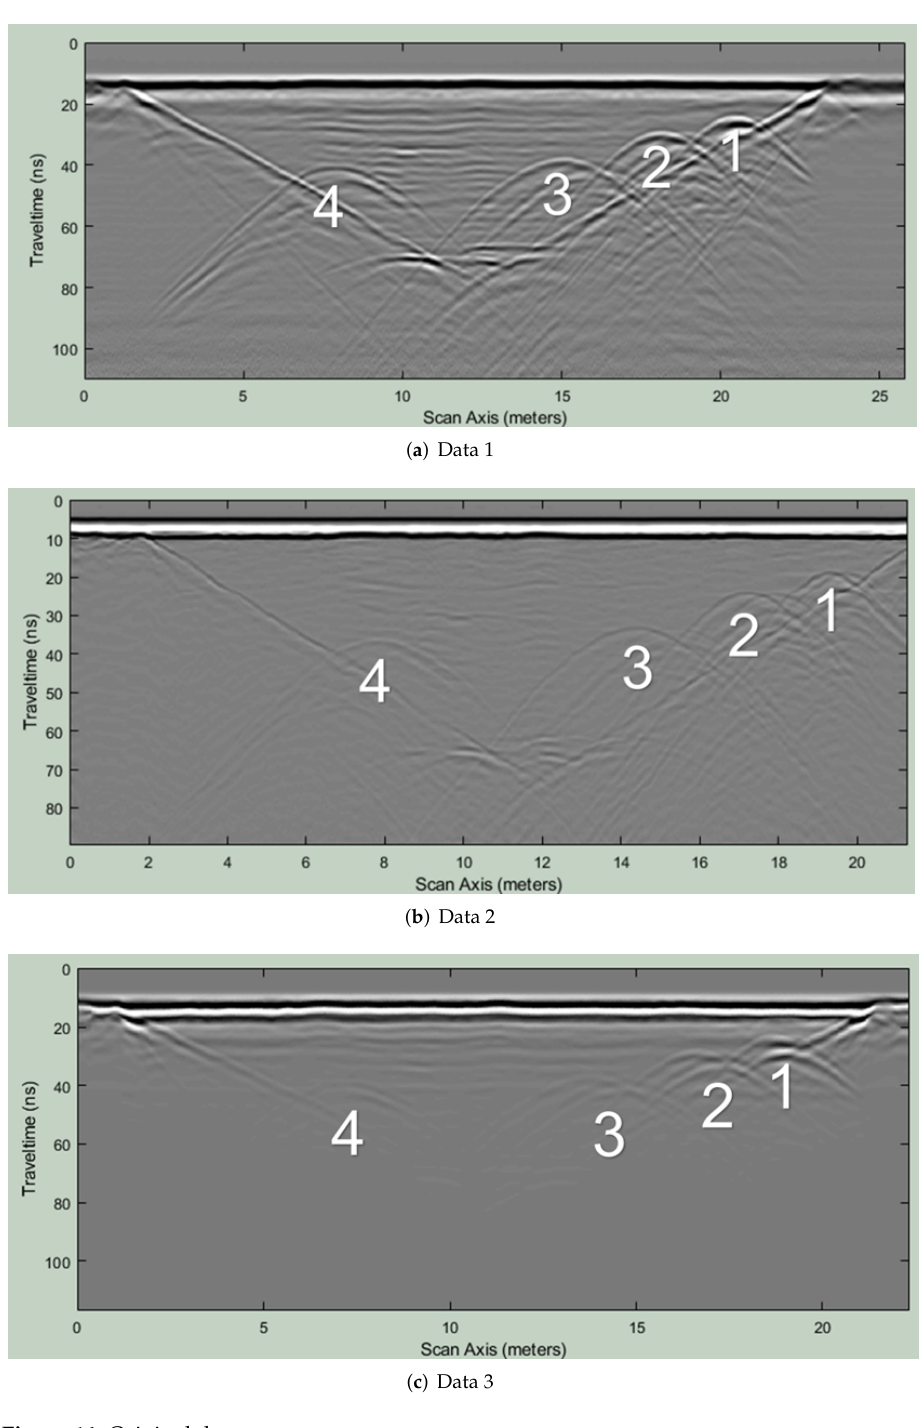
Figure 14. Original data. After correction, the average absolute error of the inversion results of the depth of hyperbolic No. 2 is 0.15 m and the average relative error is 10.0%; the average absolute error of the inversion results of the depth of hyperbolic No. 3 is 0.02 m and the average relative error is 1.1%; the concrete pipe corresponding to hyperbolic No. 4 does not give the true value of the depth, but all three inversion results are very close, with the average value of 2.36 m, coincided with the burial situation, located below the third layer of pipes, and the variance was only